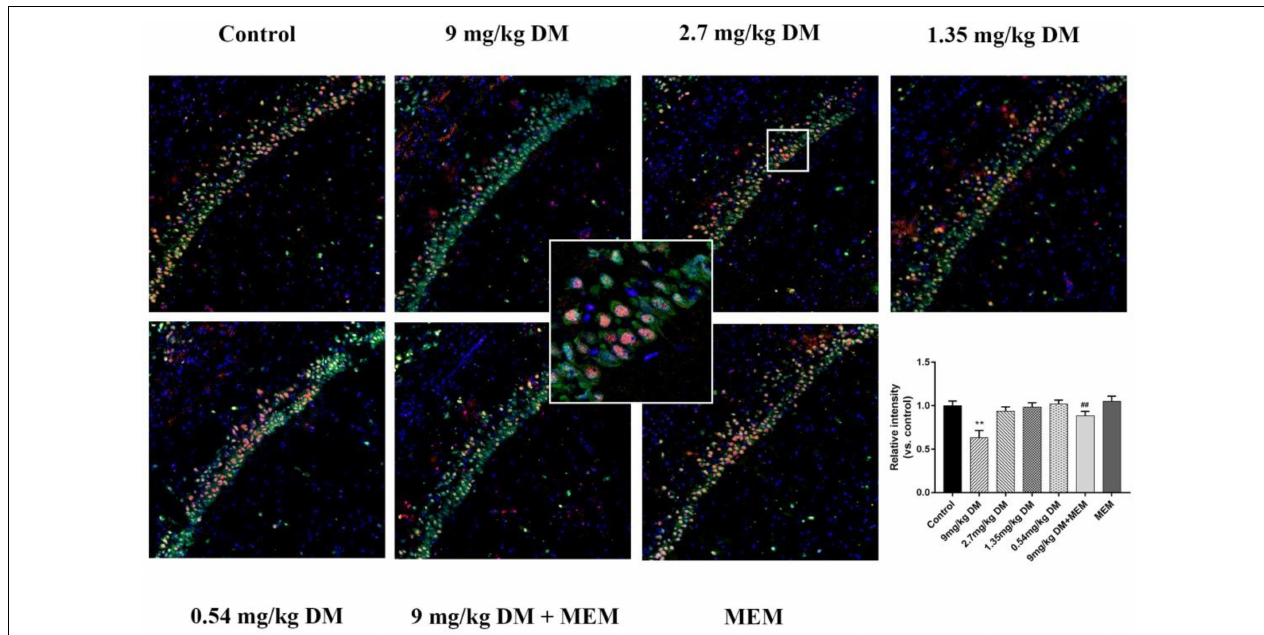
FIGURE 3 | Immunofluorescence analysis of BDNF expression in hippocampus. Representative confocal micrographs of BDNF expression in the CA1 region (BDNF staining shown in red, neurons shown in green, and DAPI counterstain in blue). Immunofluorescence staining for protein expression of BDNF in the CA1 area of hippocampus in different groups: control group, 9 mg/kg deltamethrin treated group, 2.7 mg/kg deltamethrin treated group, 1.35 mg/kg deltamethrin treated group, 0.54 mg/kg deltamethrin treated group, co-administered of 9 mg/kg deltamethrin and memantien group, memantine group. Scale bar = 200 µ m. Data are mean ± SD. n = 12 rats/group. ∗∗ P < 0.01 compared to control group, ## P < 0.01 compared to 9 mg/kg deltamethrin treated group. DM: deltamethrin, MEM: